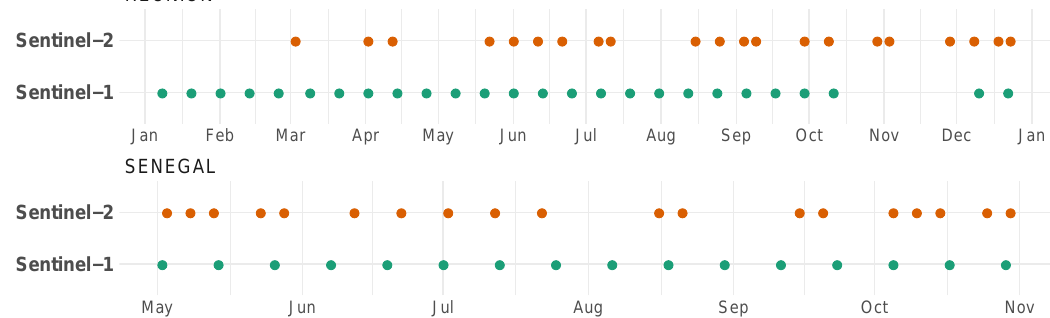
Figure 1. Overview of the acquisition dates of Sentinel-1 (S1) and Sentinel-2 (S2) images over the two study sites. S2 acquisitions were sparsed due to the ubiquitous